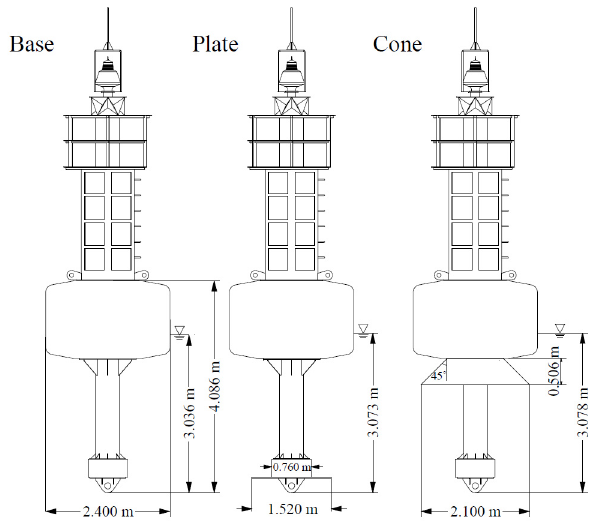
Figure 5. Cross-section views of target lightweight light buoys. Figure 5. Cross ‐ section views of target lightweight light buoys.